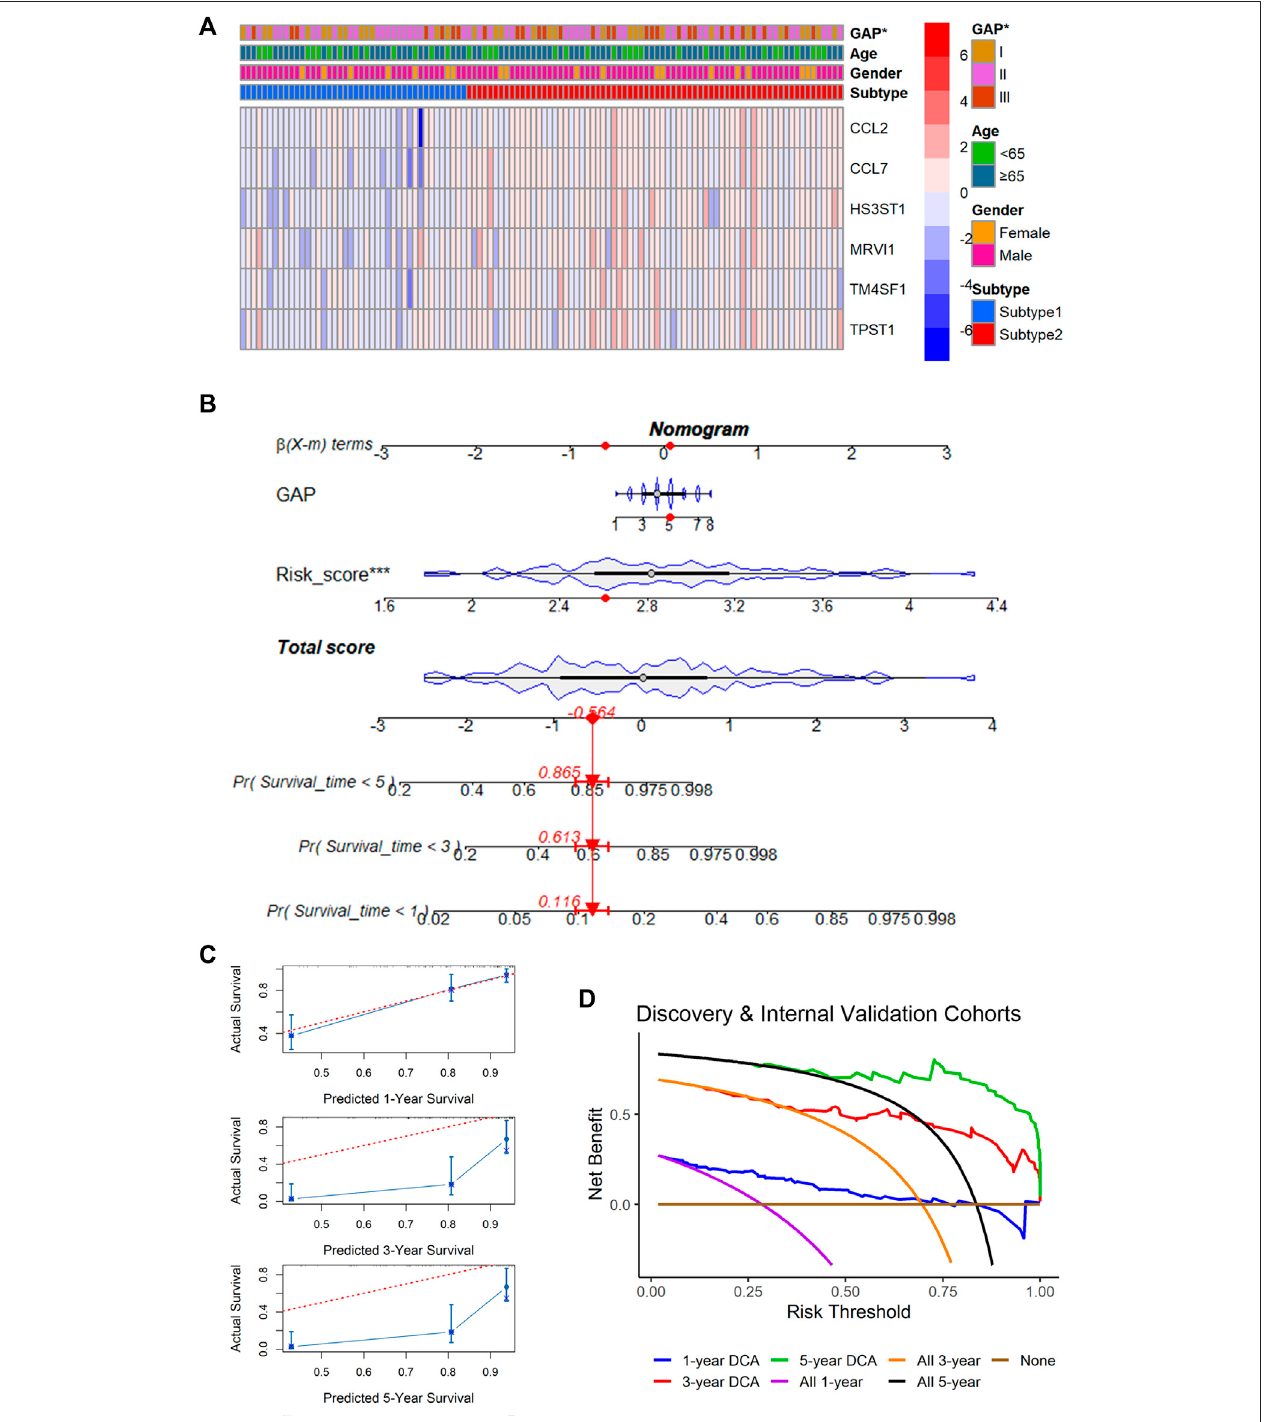
FIGURE 7 | Correlation between m7GPS and clinical features and an application of the m7CPS in the nomogram. (A) Correlation between m7GPS and clinical features; the p -value is calculated based on Wilcoxon rank-sum test. (B) The nomogram is based on the GAP and m7GPS; the red dots in the nomogram represent the clinical features of patient GSM1820740. (C) Calibration curves assess the accuracy of the nomogram in predicting the survival probabilities of IPF individuals. (D) Decision curve analysis (DCA) demonstrates positive net bene fi ts of the nomogram for IPF patients.